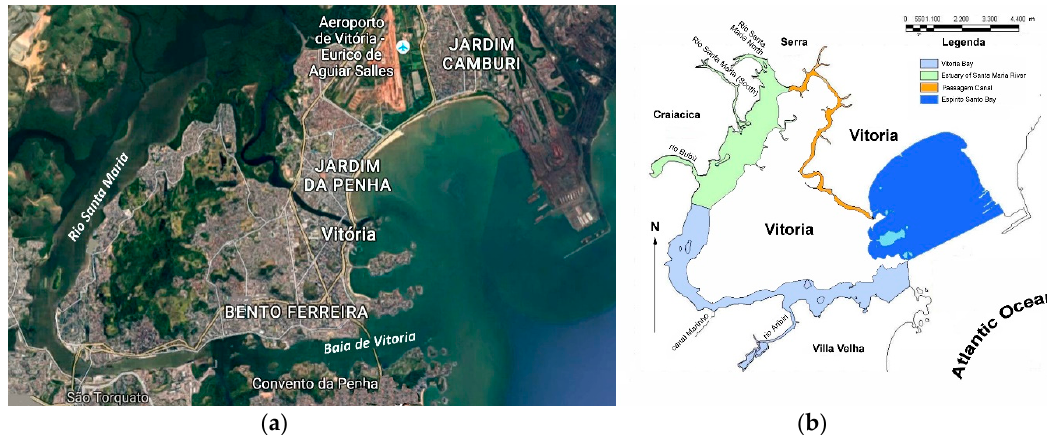
Figure 2. Detailed maps of the study area: ( a ) the physical map shows urban and industrial areas, while ( b ) details of the different water bodies are reported.